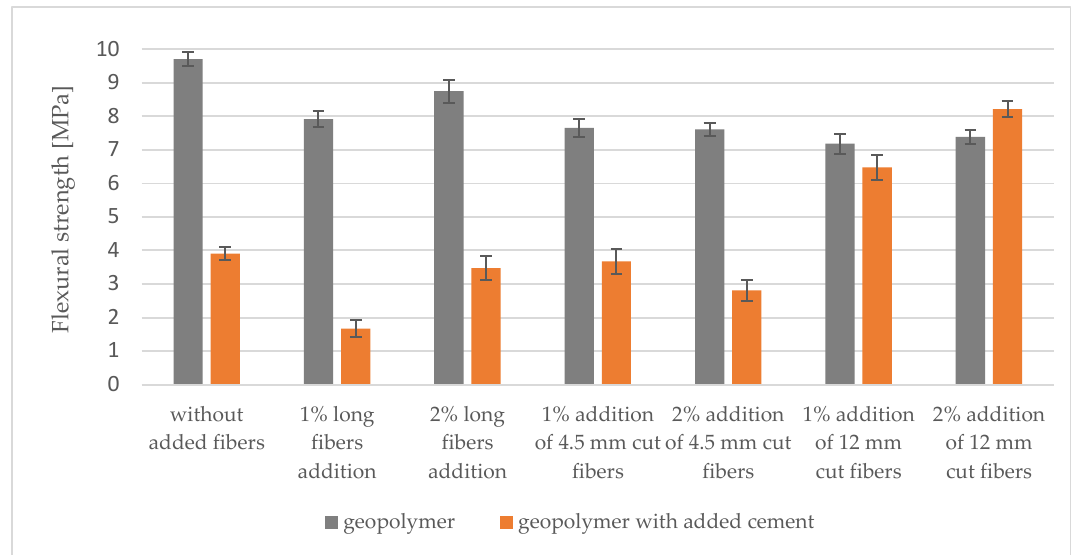
Figure 12. Flexural strength of E-glass fiber-reinforced geopolymers and geopolymers with cement addition.